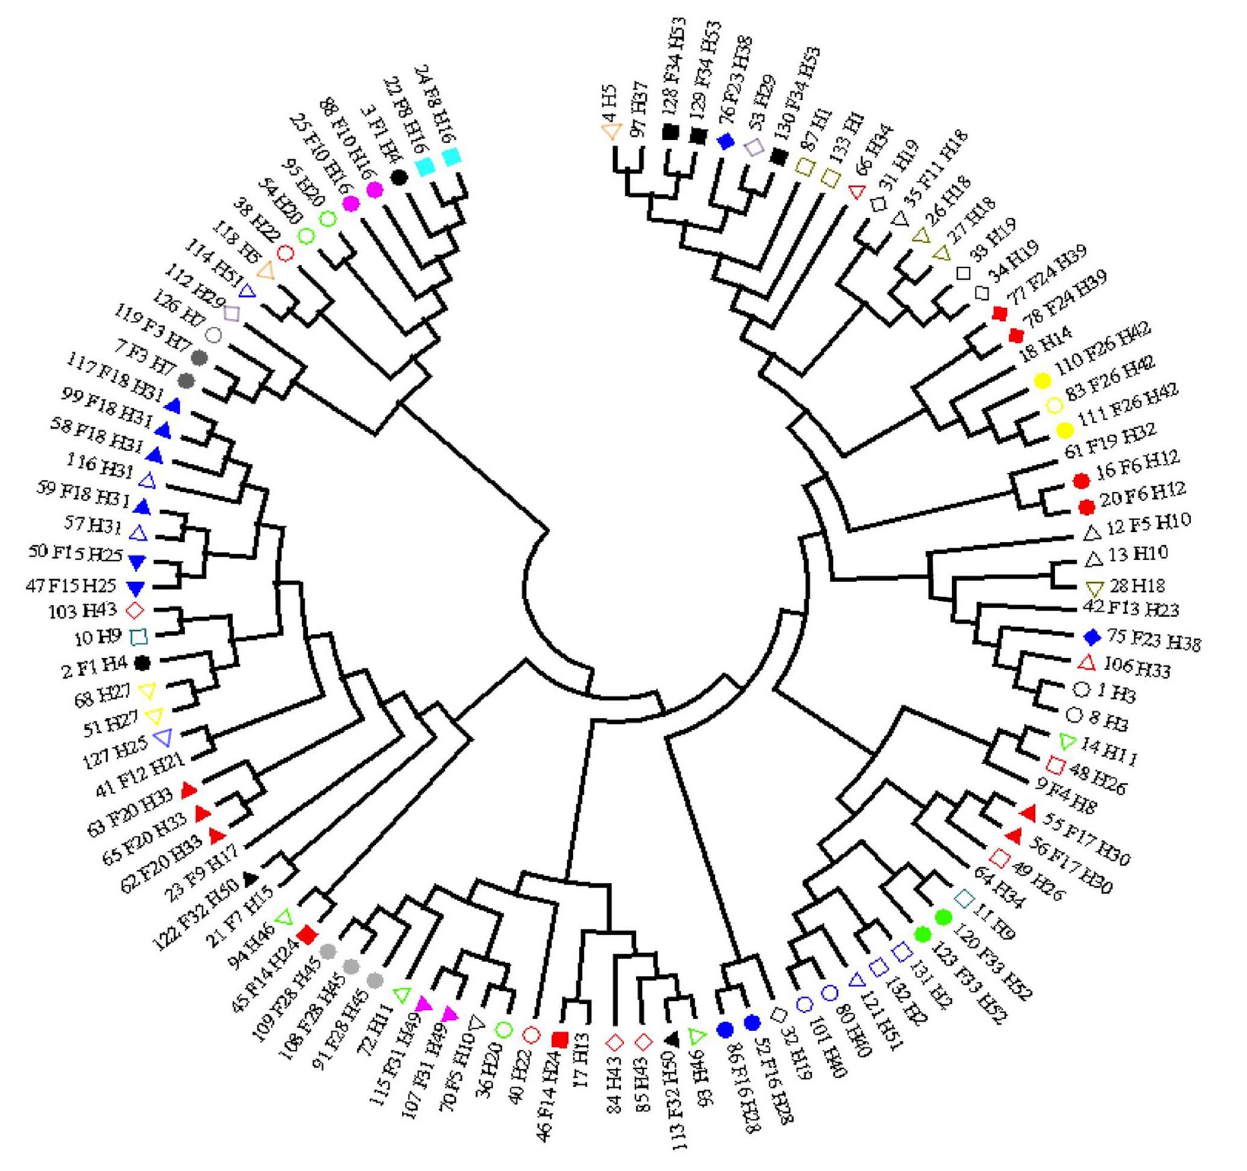
Figure 1. Phylogenetic tree from the HCV sequences of 105 patients infected by the genotype 4a. Same shape filled with same color means same house and same family. Same shape empty means same house, but not the same family. Absence of symbol means no connection to other participant with sequence.